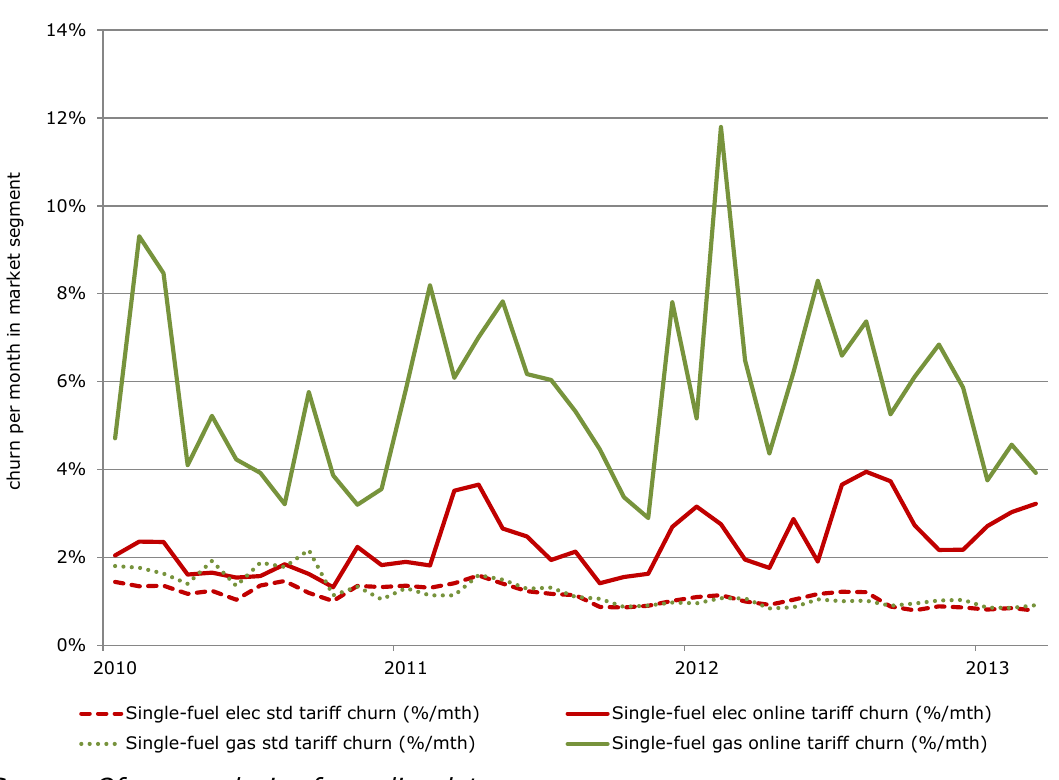
Figure 26: Single-fuel online customer churn versus single fuel standard customer